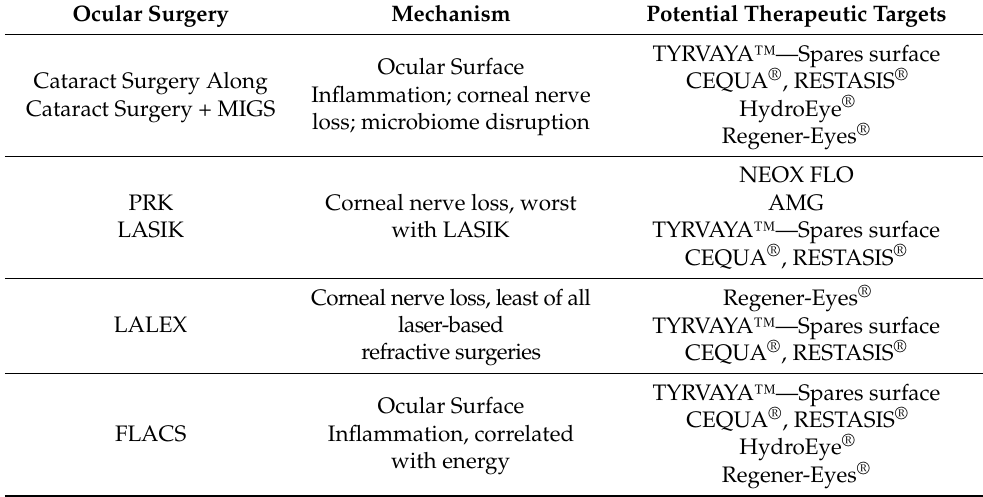
Table 1. Summary of Unique Pathways to Surgical Temporary Ocular Discomfort Syndrome (STODS) Following Different Ocular Surgeries.